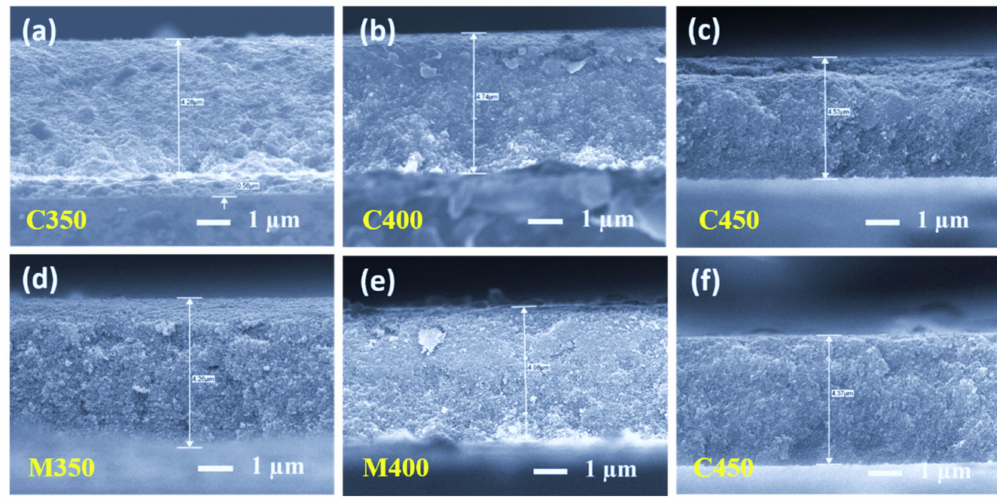
Figure 3. Scanning electron microscopy cross-sectional images of ( a – c ) Conventionally sintered titania films, and ( d – f ) Microwave sintered titania films.